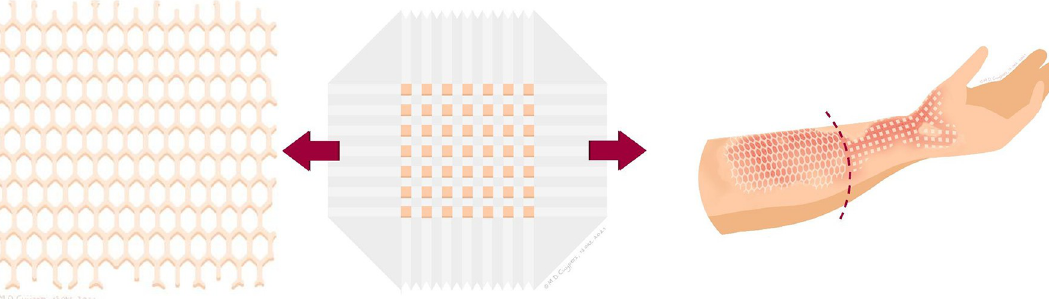
Fig 2. a. Illustration of a mesh graft. b. Illustration of Meek micrograft on a plisse´. c. Illustration of a wound divided into two study areas, one covered with a mesh graft and one with a Meek micrograft.